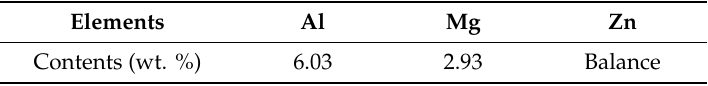
Table 2. Chemical composition of Zn-6Al-3Mg alloy baths (wt.